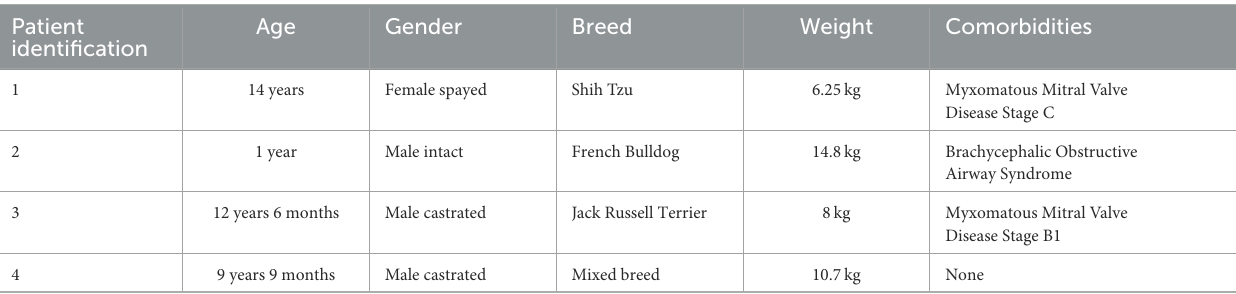
TABLE 1 Patient characteristics.